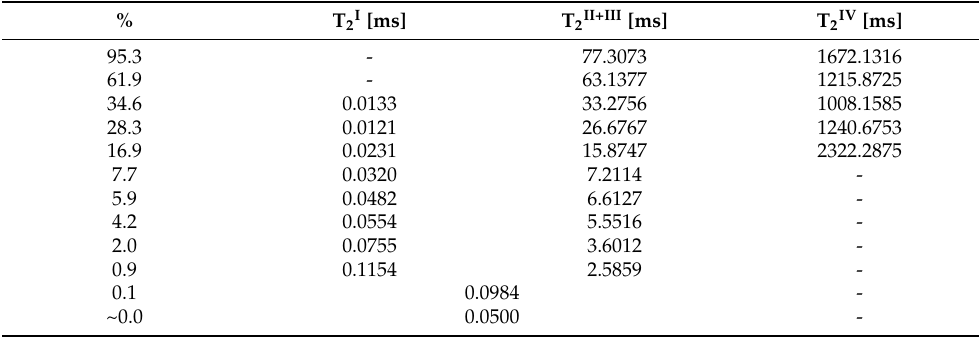
Table A2. Line position for SBA-15 in series of water saturations. I—OH groups, II—intra pore water, III—inter pore water, IV—free